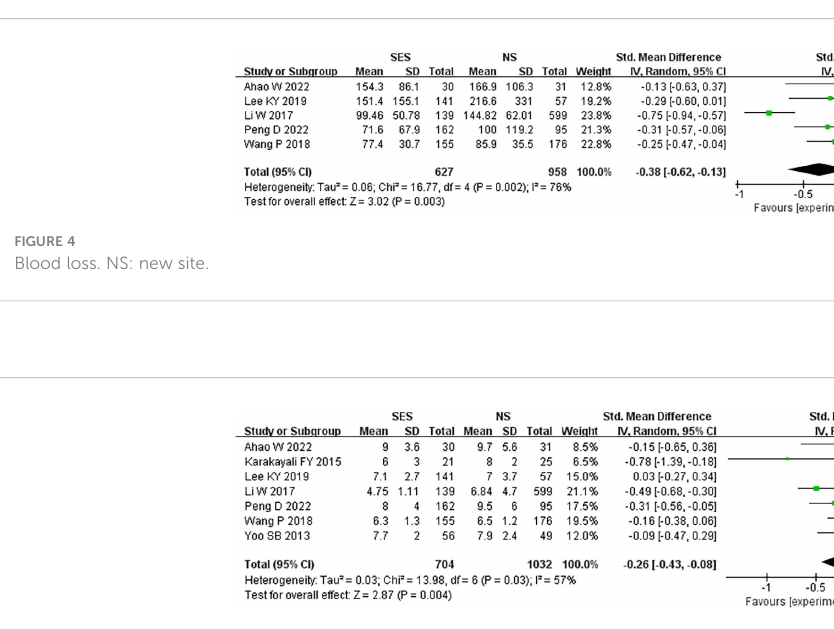
FIGURE 5 Postoperative hospital stay. NS: new site.